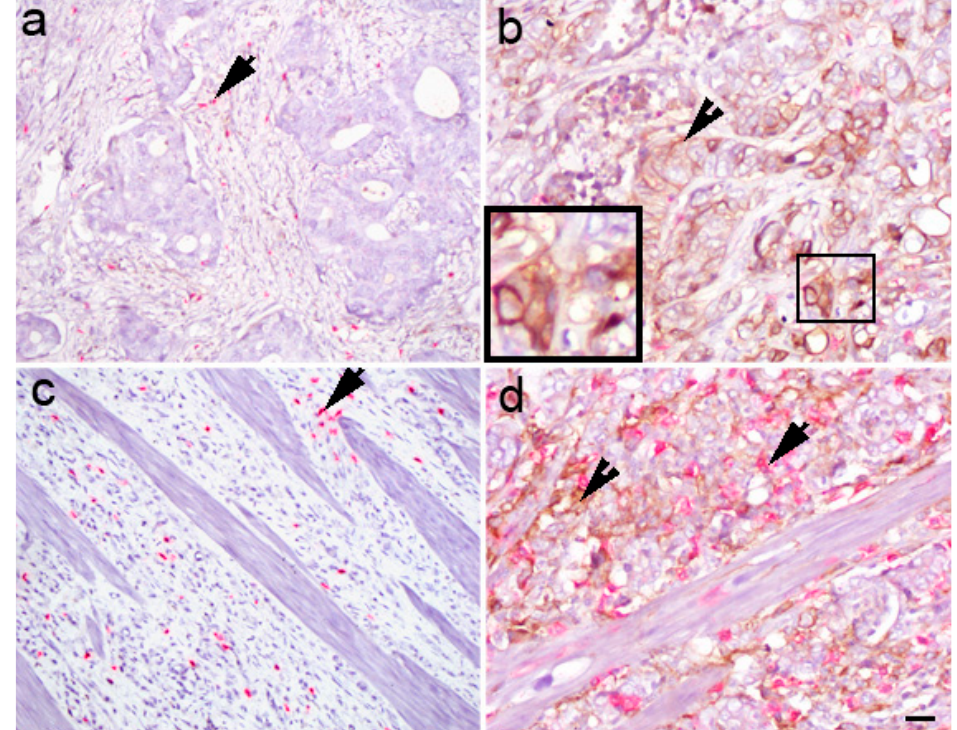
Figure 3. Double immunohistochemistry with PD-L1/CD8 staining in gastric cancer. Different PD-L1 expression levels (arrowheads) in gastric cancer: negative (stage 3B) ( a ) and positive (stage 2B) ( b ) in intestinal type, and negative (stage 4B) ( c ) and positive (stage 3B) ( d ) in diffuse type. CD8 + cells are red (arrows). Scale bar 25 µm.